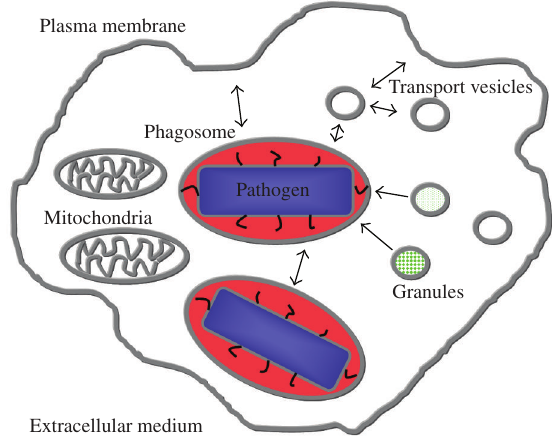
FIGURE 1: Cellular compartments in phagocytosis. The phagocyte contains multiple membrane-bound compartments, only some of them are included here. The vesicles mostly belong to the endosomal pathway. The neutrophil granules belong to several types with different content. Some of these compartments exchange membrane and liquid (arrows). The phagosome is filled with a pathogen (blue) surrounded by a limited phagosomal solution